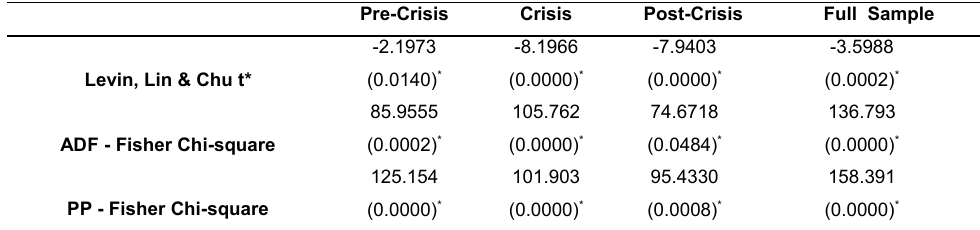
Table 4b: Panel Unit Root Test for